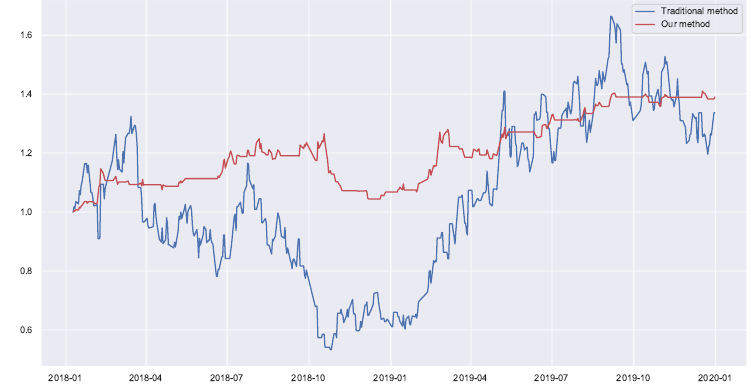
Figure 4. Comparison of the return rate obtained by our feature extraction method and traditional